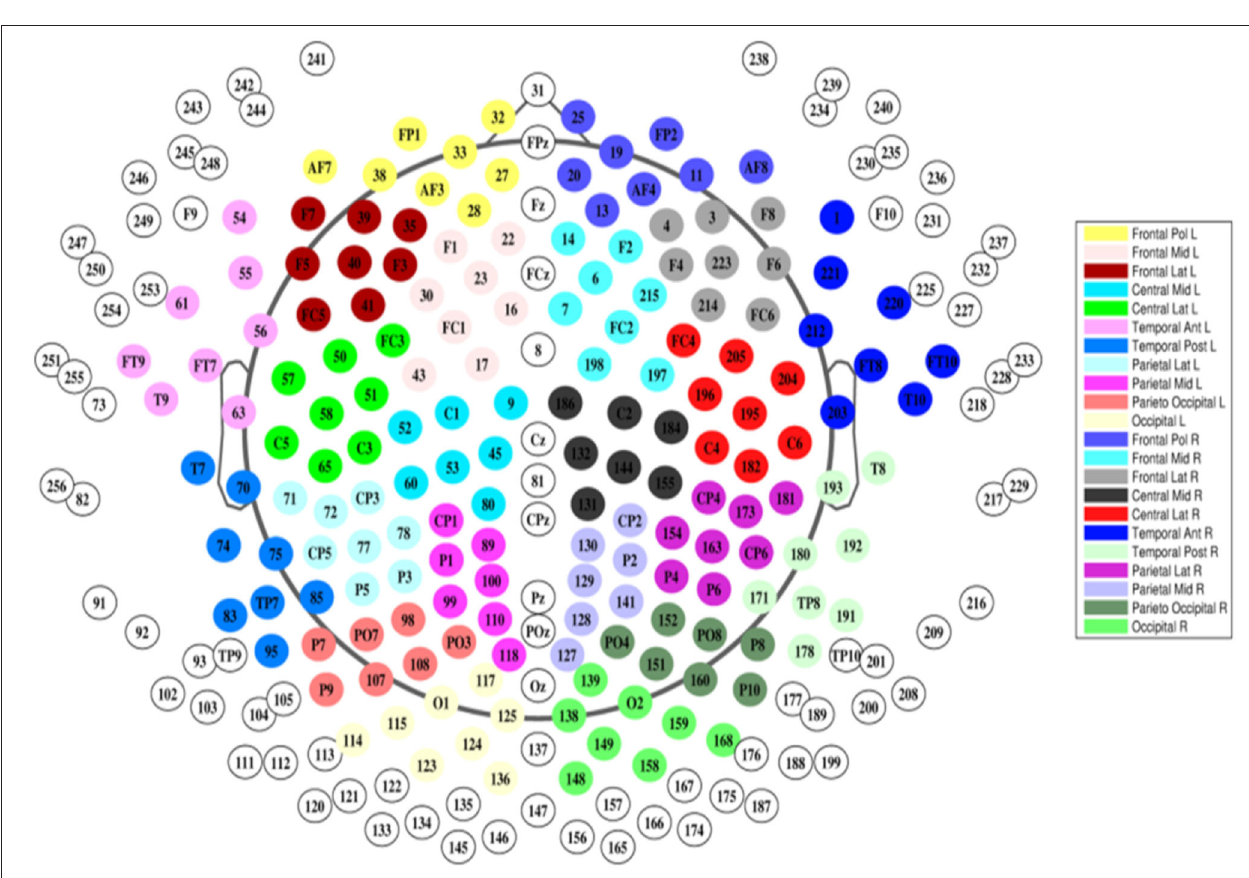
female. Presented results are obtained by averaging 500